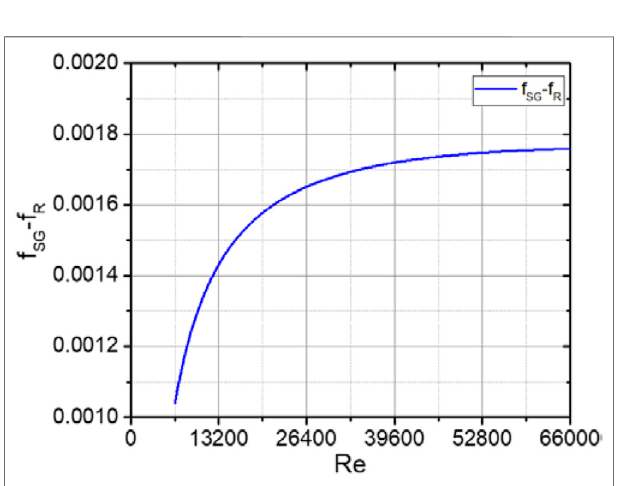
FIGURE 8 | Spacer grid effect on the friction factor downstream of the spacer grid.